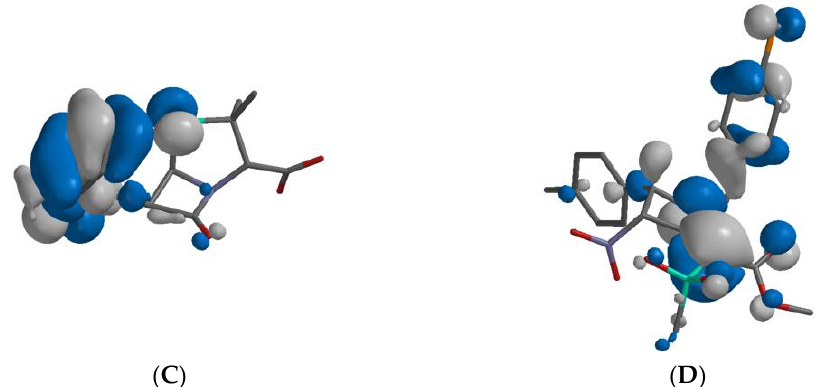
Table 2. Comparison of the Main Stereoelectronic Features of the Azetidine Rings in Penicillin G and 2-Nitroazetidine 22 Figure 4. Geometry optimized models (DFT ῶ B97X-D/6-31G*) of the structures of penicillin G ( A ) and nitroazetidine 22 as Obtained through Quantum-Mechanical Calculations (DFT ῶ B97X-D/6-31G*//DFT ῶ B97X-D/6-31G*, Gaseous Figure 4. Geometry optimized models (DFT ( B ) and corresponding HOMO density maps (( C ) and ( D ), respectively).